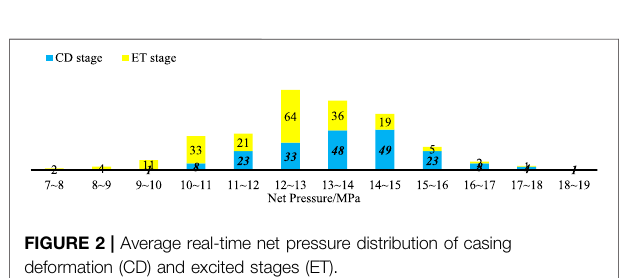
FIGURE 2 | Average real-time net pressure distribution of casing deformation (CD) and excited stages (ET).